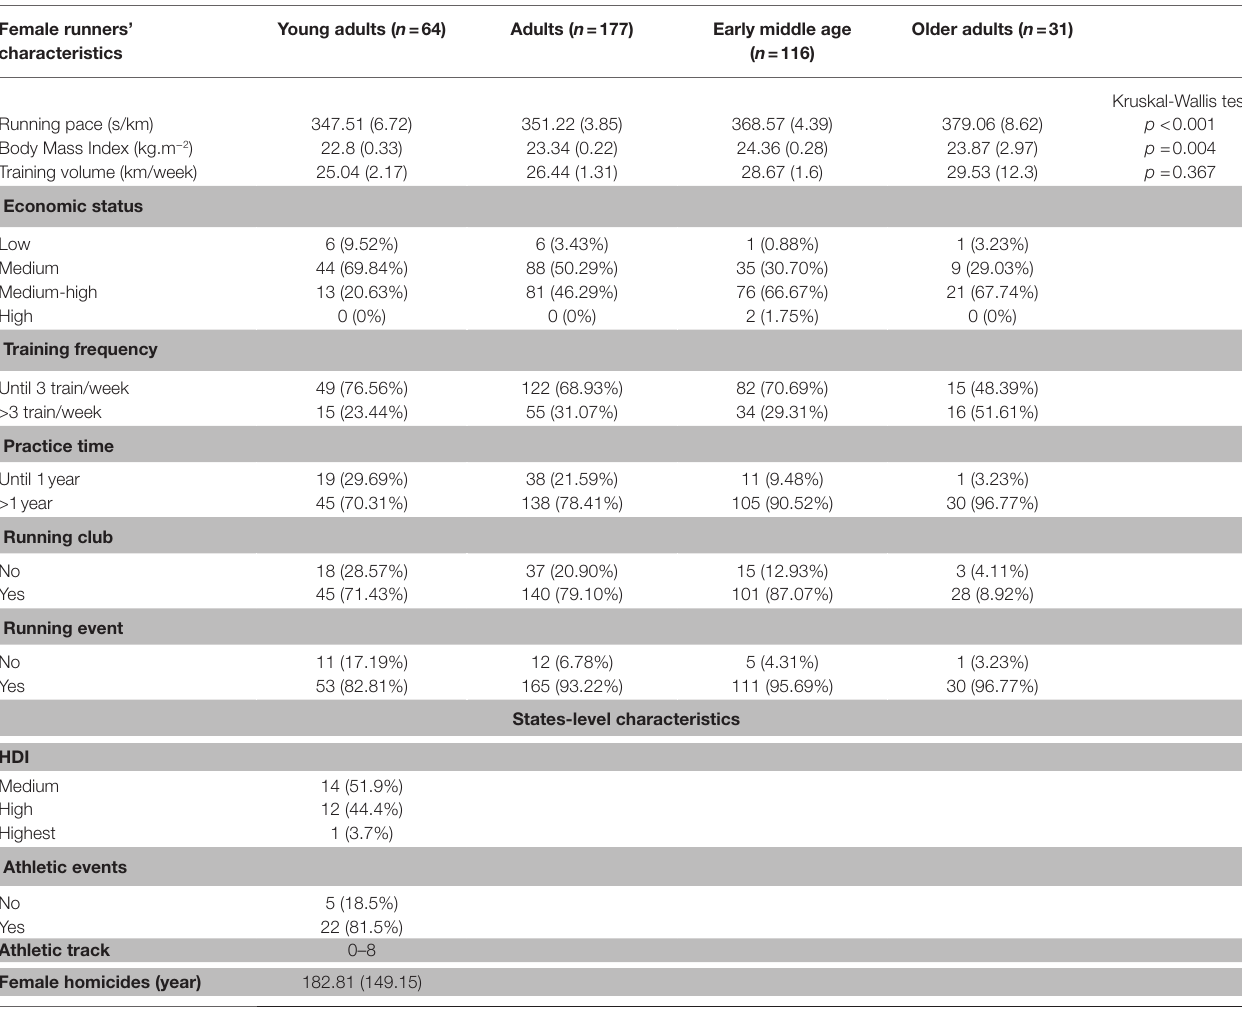
TABLE 1 | Descriptive information of runners, by age group (mean (standard error) and frequency (%)), and states-level characteristics. Female runners’